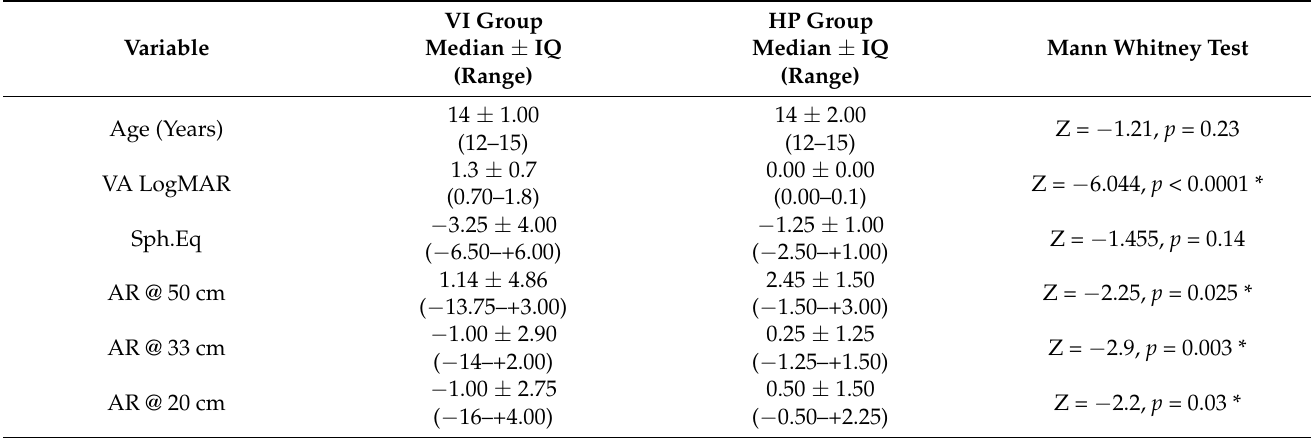
Table 1. Summary of the participants’ characteristics and error of accommodation under the three conditions: 50, 33, and 20 CM in both participants groups.